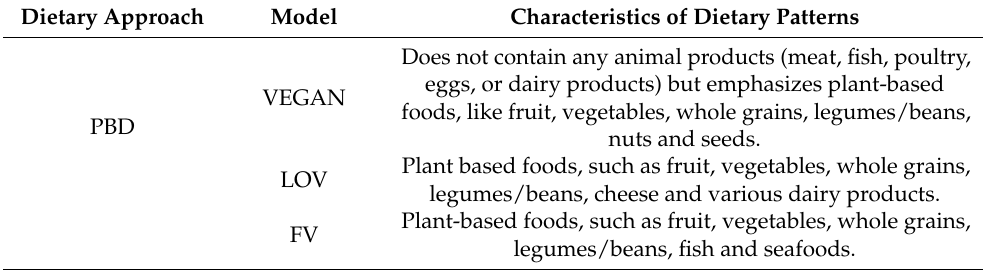
Table 1. Examples of plant-based dietary patterns. FV, fish-vegetarian; LOV, lacto-ovo-vegetarian; PBD, plant-based diet.